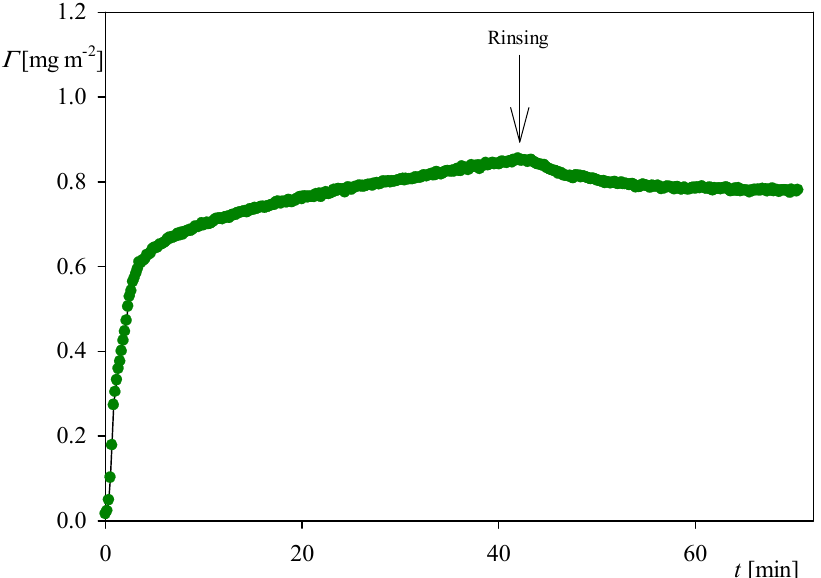
Figure 4. The kinetic of myoglobin adsorption on the silica sensor determined by OWLS, flow rate 2.5 × 10 − 3 cm 3 s − 1 , bulk protein concentration equals to 5 mg L − 1 , ionic strength 0.01 M, pH 4. At the time of 45 min the rinsing run was initiated by flushing pure electrolyte at the same ionic strength and pH.